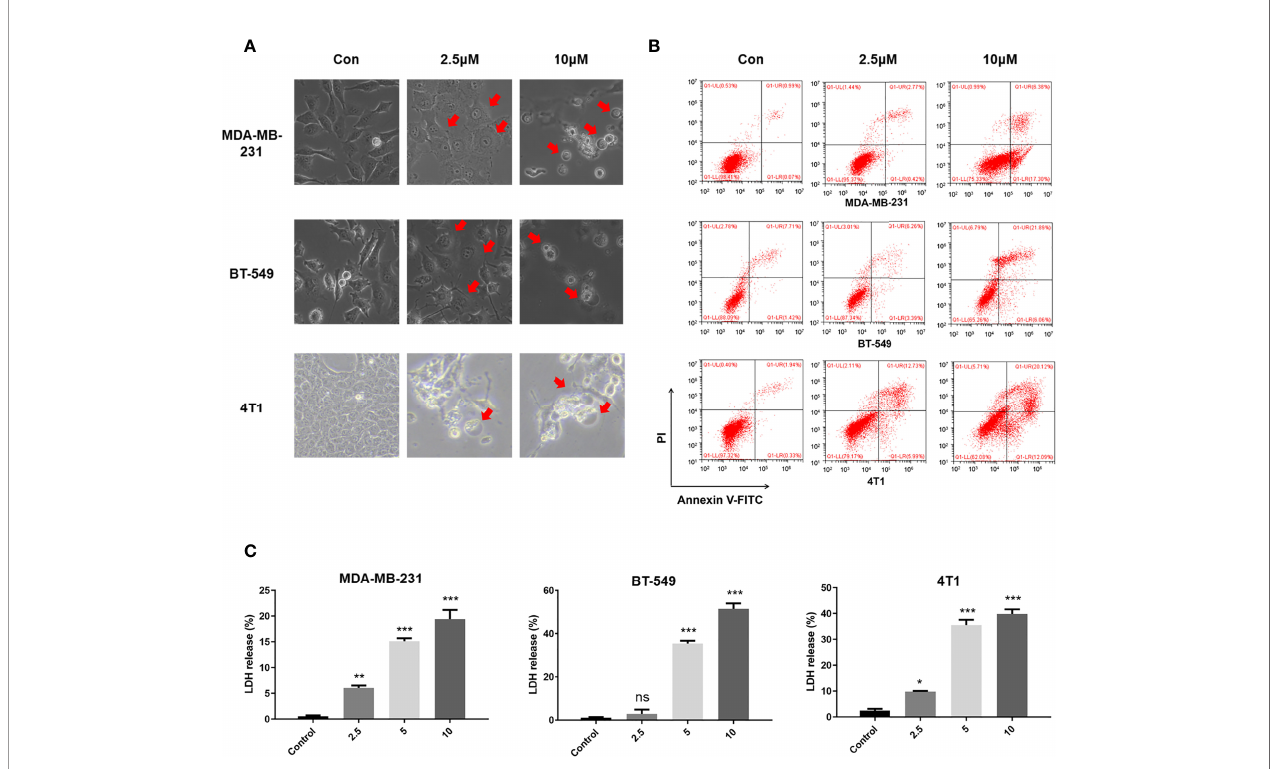
FIGURE 4 | GW-8510 induces pyroptotic cell death in TNBC cells. (A) Representative phase-contrast images of GW-8510 treated cells with 0, 2.5, and 10 m M for 24 h. Original magni fi cation, ×400. (B) Flow cytometry analysis of GW-8510-treated TNBC cells stained by Annexin V-FITC and PI. (C) Release of LDH from TNBC cells treated with indicated concentration of GW-8510 for 24 h. *P < 0.05, **P < 0.01, and ***P < 0.001 were considered statistically signi fi cant.